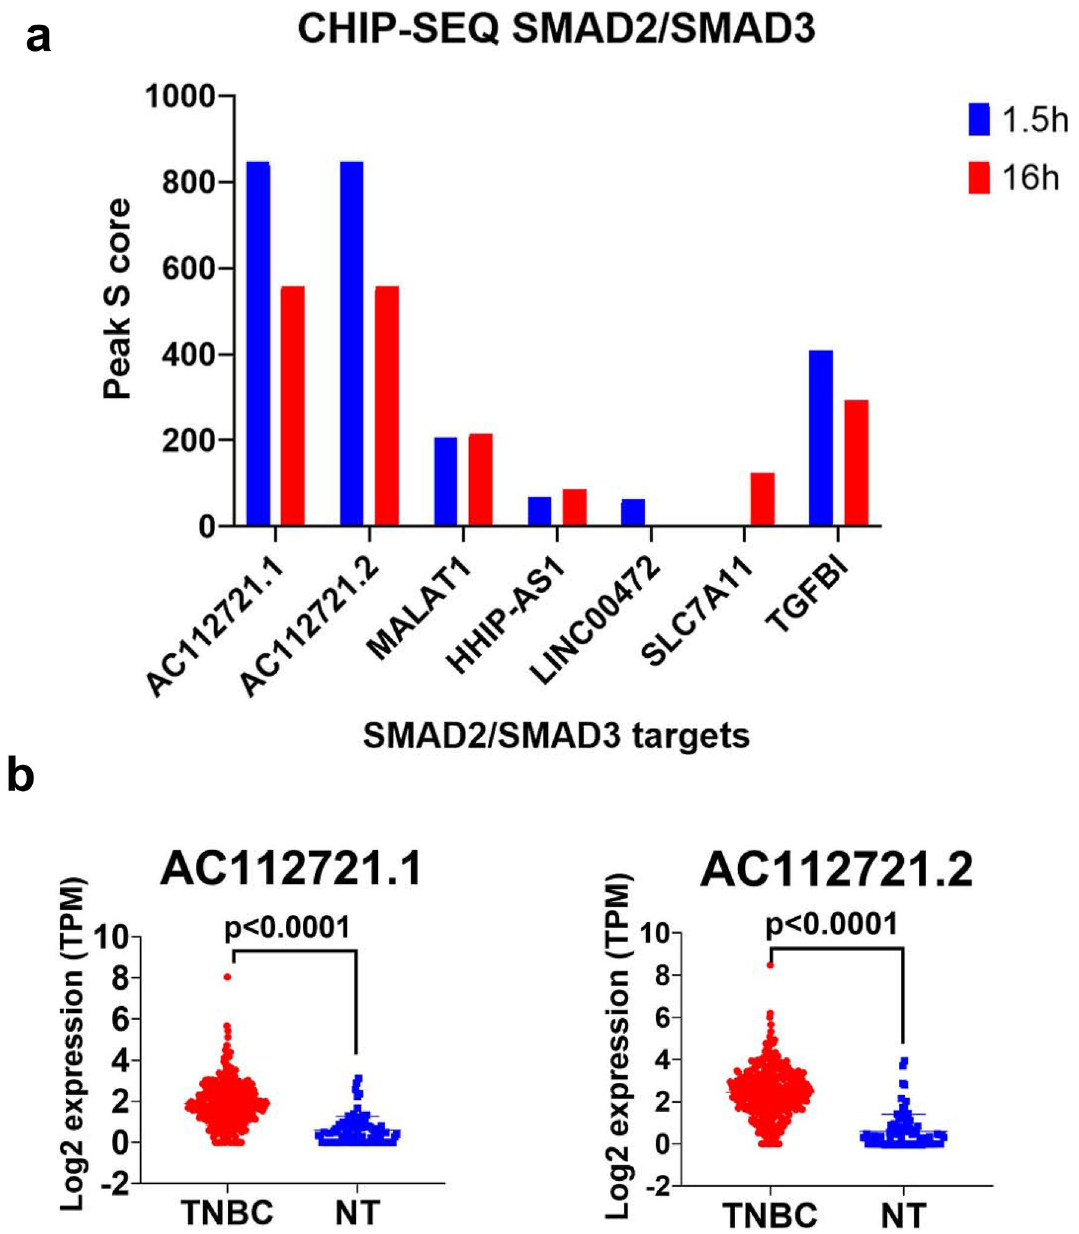
Figure 6. ( a ) ChIp-Seq analysis demonstrating direct binding of SMAD2/SMAD3 to the promoter region of the indicated lncRNAs. TGFBI was used as positive control. ( b ) Expression of AC112721.1 and AC112721.2 in a cohort of 360 TNB and 88 normal breast